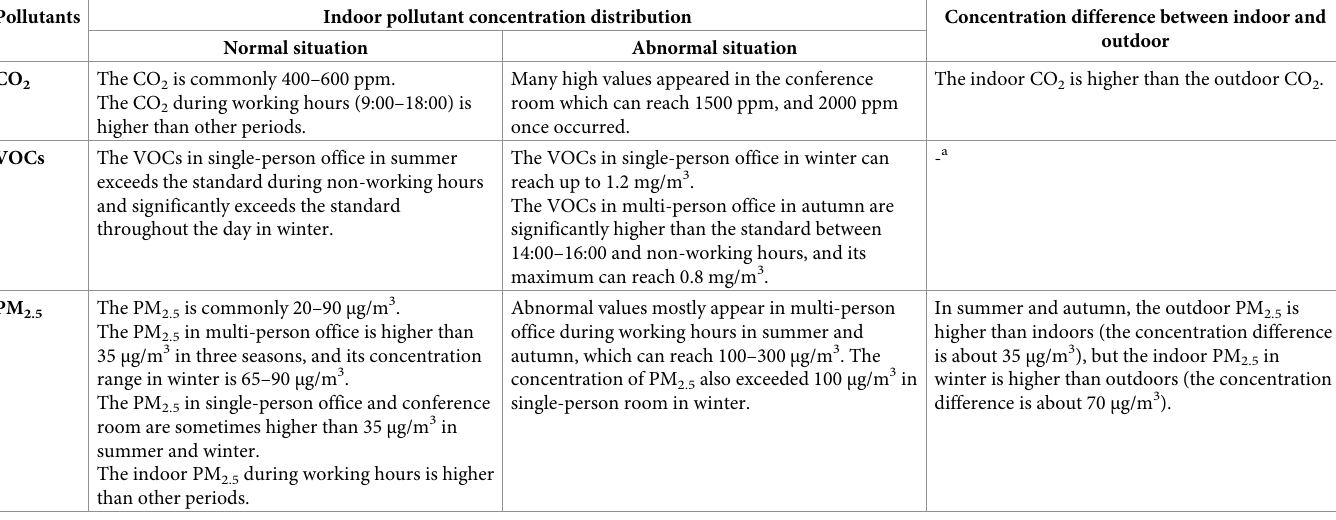
Table 2. Indoor and outdoor concentration distribution of CO 2 , VOCs, and PM 2.5 in office buildings. Pollutants Indoor pollutant concentration distribution Concentration difference between indoor and